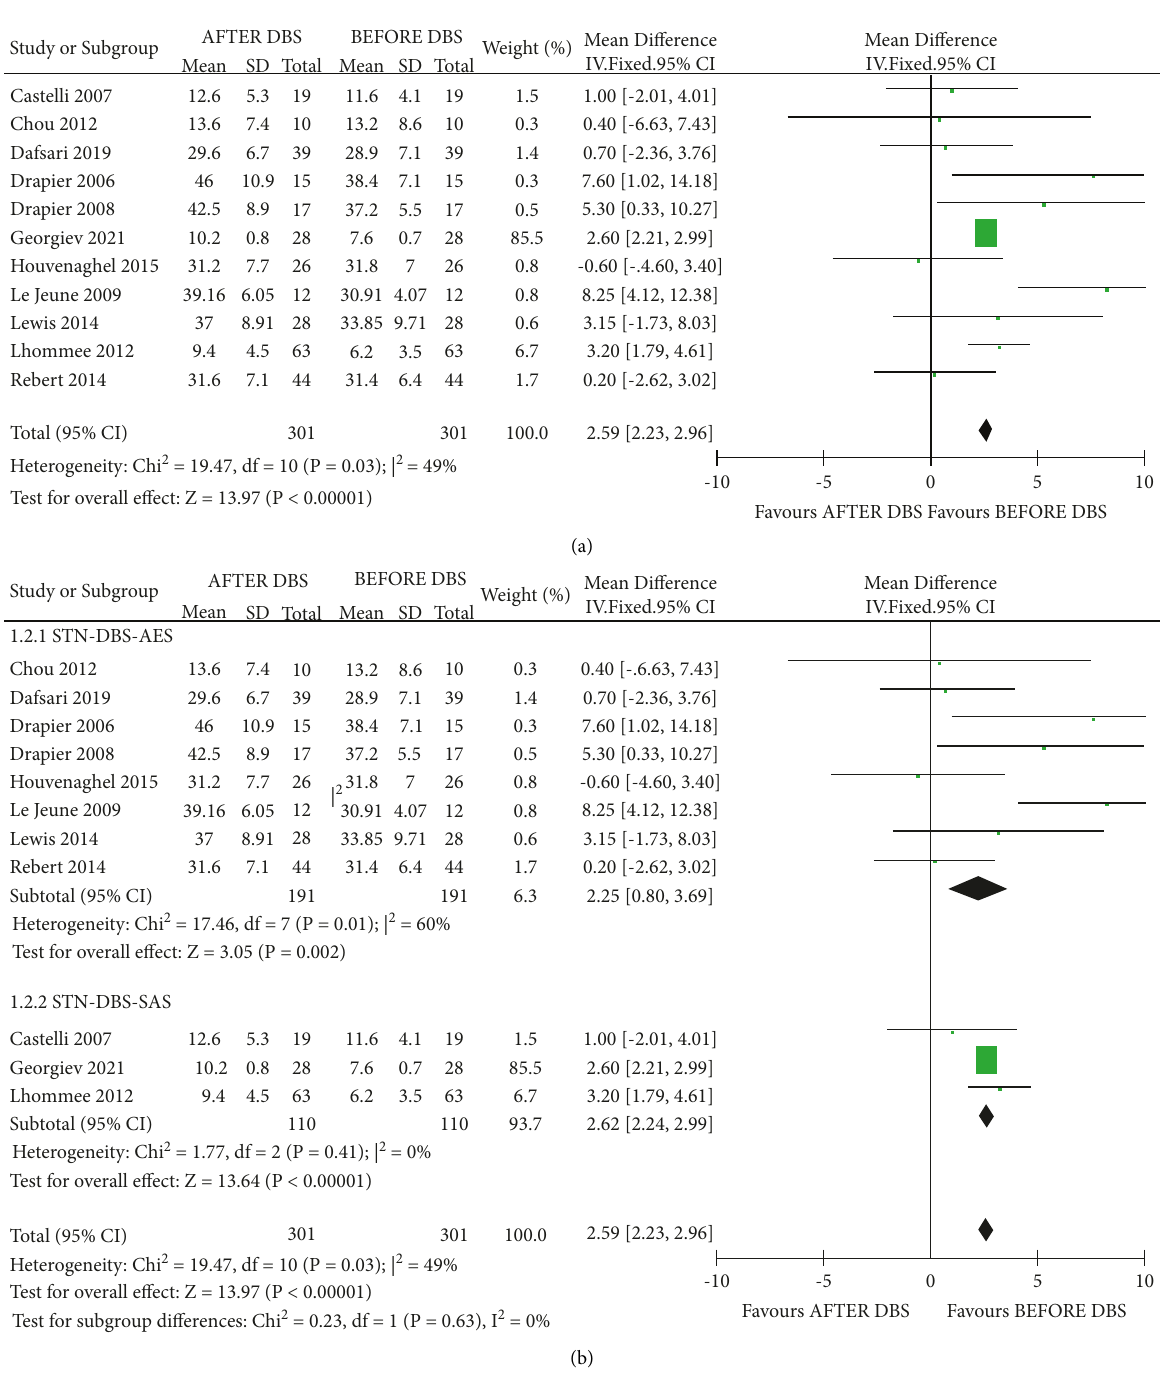
Figure 3: Forest plot for the change in apathy pre-STN-DBS and post-STN-DBS. (a) Overall effects. (b) Subgroup